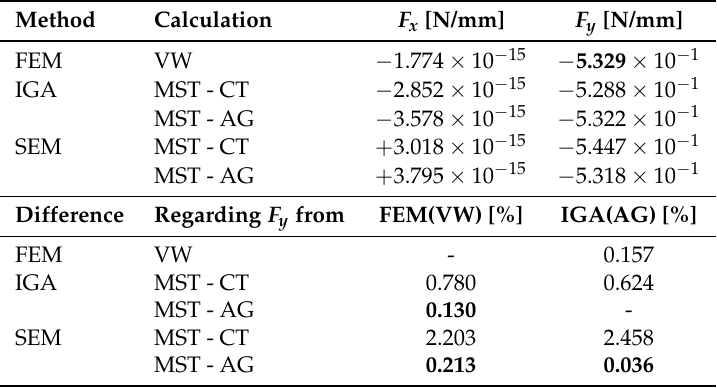
Table 2. Force comparison for Benchmark I reference